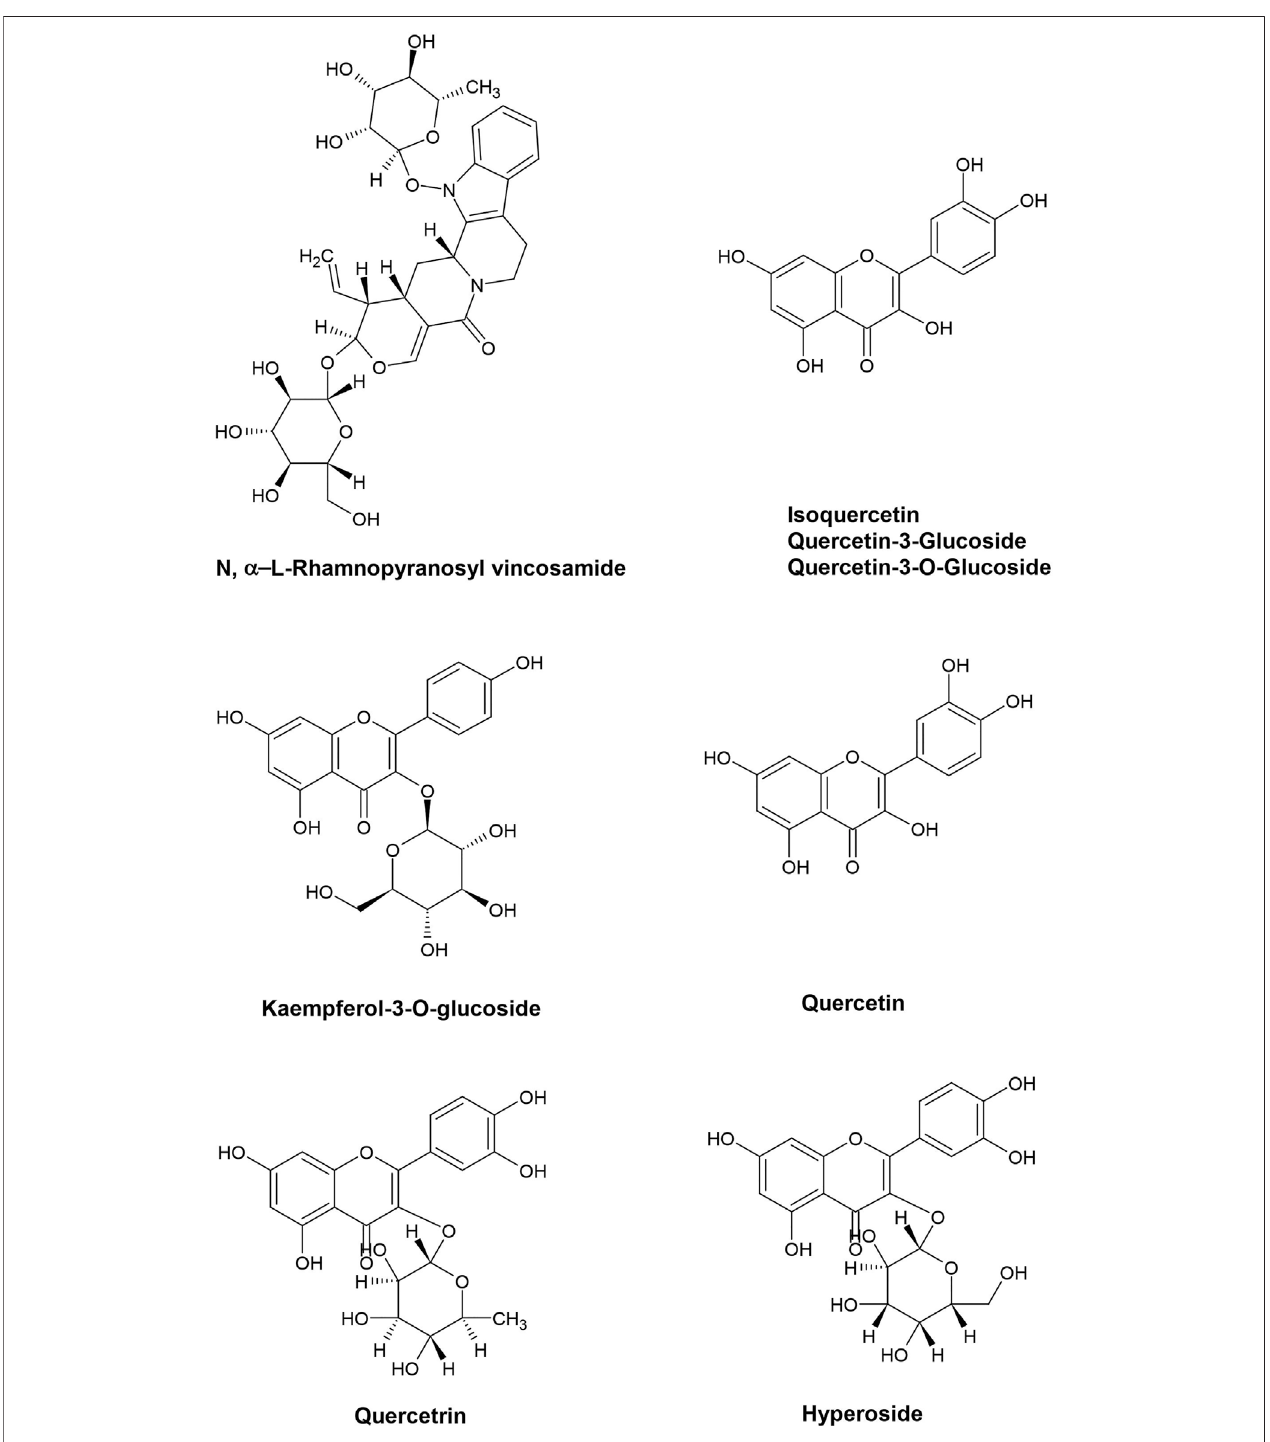
FIGURE 2 | Chemical structures of prominent Moringa oleifera bioactive compounds that have role in combating CVDs.